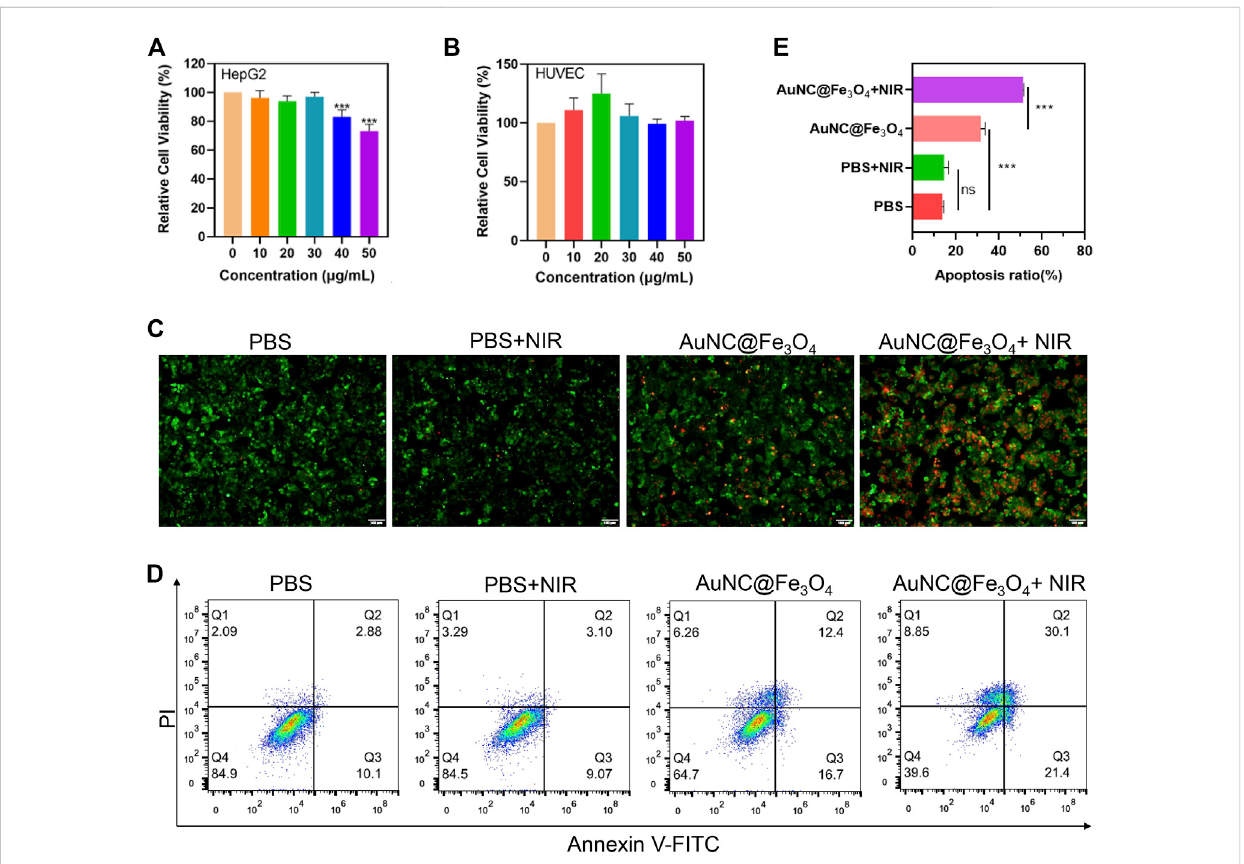
FIGURE 4 Evaluation for anti-tumor effect of AuNC@Fe 3 O 4 in vitro . (A) Cell viability of HepG2 cells treated with AuNC@Fe 3 O 4 for 24 h. (B) Cell viability of human umbilical vein endothelial cells (HUVEC) cells treated with AuNC@Fe 3 O 4 for 24 h. (C) Calcein-Am/propidium iodide (PI) staining of HepG2 cells under different conditions. Scale bar: 100 μ m. (D) Apoptosis analysis of HepG2 cells with different treatments. (E) The histogram results of apoptotic HepG2 cells derived from (D) . * 0.01 < p < 0.05, ** 0.001 < p < 0.01, and *** p < 0.001.